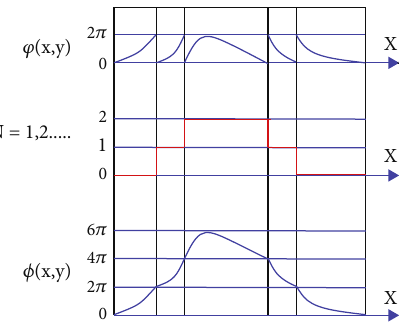
Figure 3: Wrapped phases φ ð x , y Þ and corresponding continuous phases ϕ ð x , y Þ .